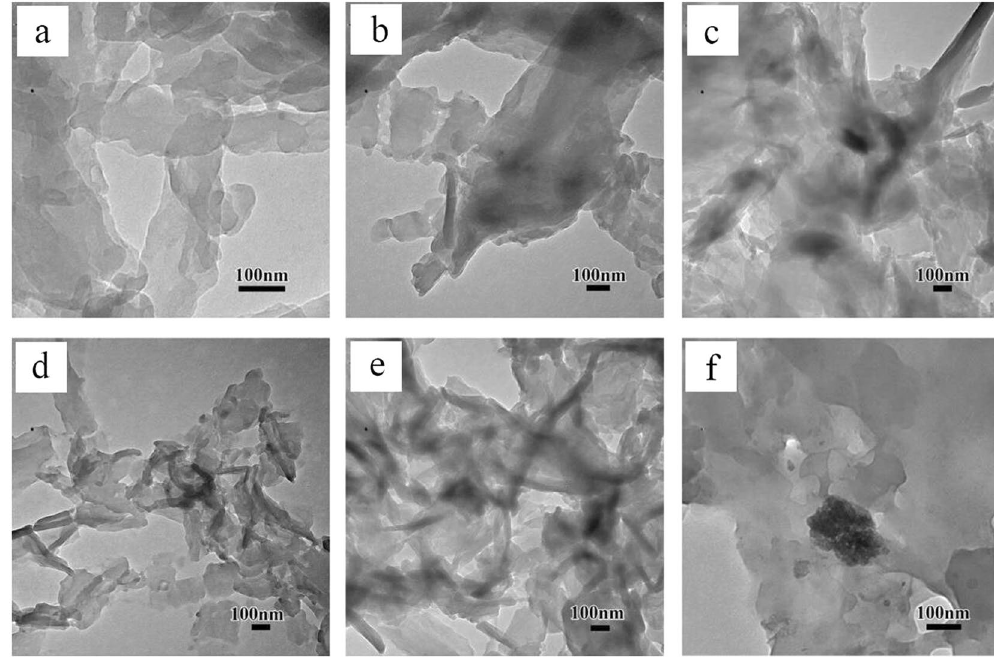
Figure 1. TEM micrographs of PPS/C 60 powder with different weight fractions of C 60 ( a ) Pure PPS; ( b ) 0.5 wt%; ( c ) 1 wt%; ( d ) 2 wt%; ( e ) 5 wt%; ( f ) 10